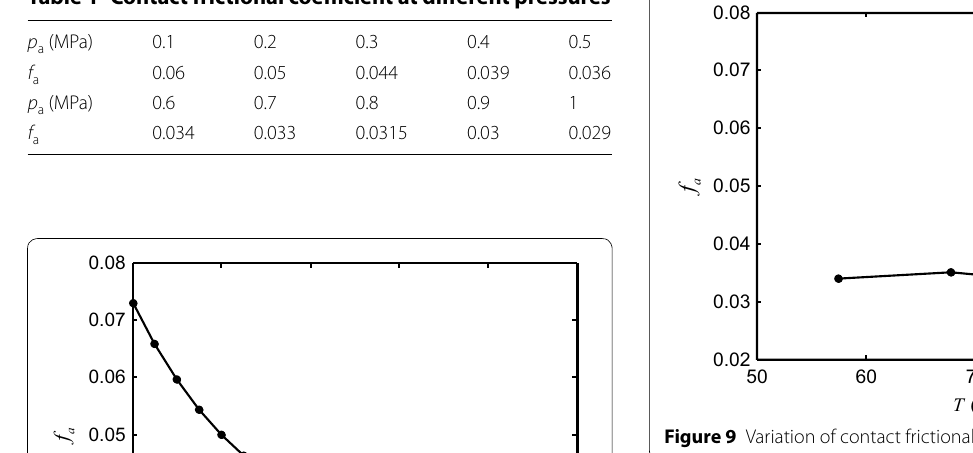
Figure 9 Variation of contact frictional coefficient with